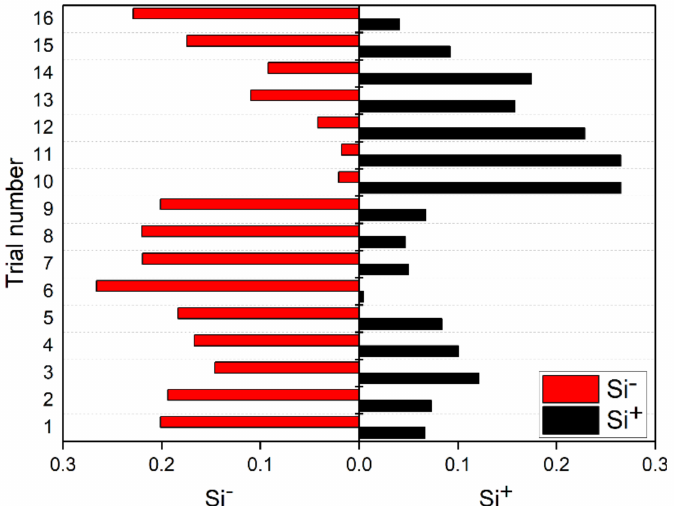
Figure 2. Euclidean distances of the alternative trials from ideal and anti-ideal solutions in TOPSIS for case study 1.